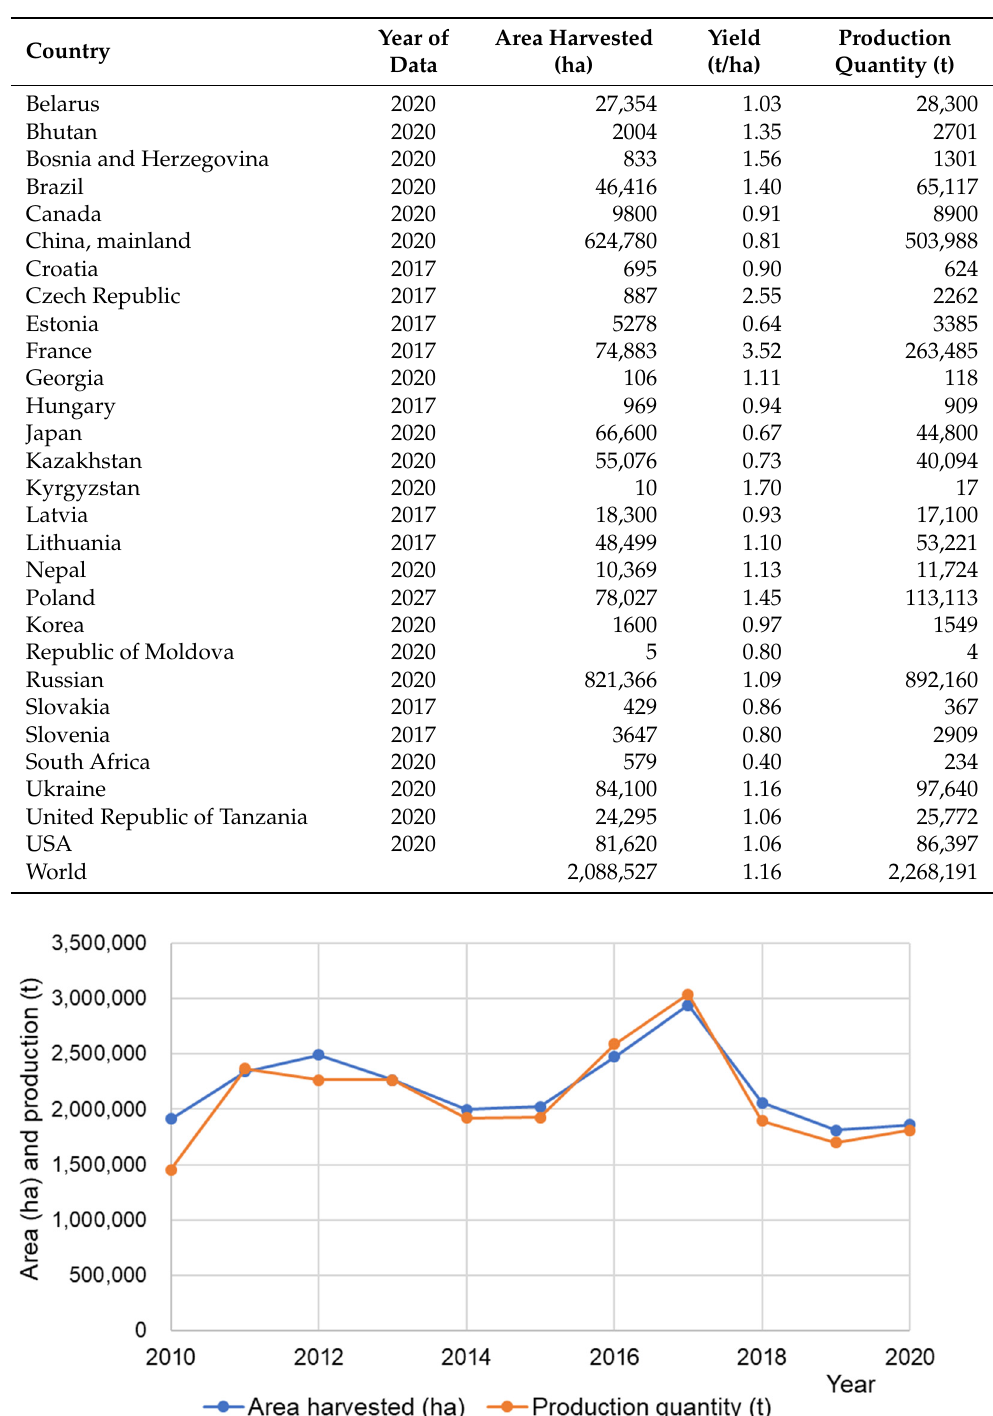
Table 1. Crops of buckwheat ( Fagopyrum spp.) by countries and in the world [18].